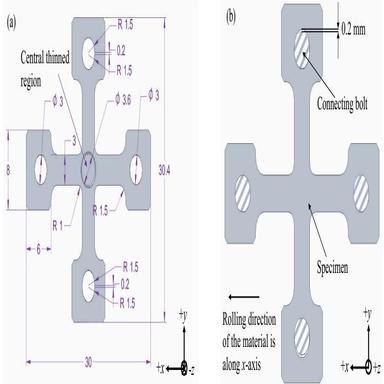
Design of (a) strain path change specimen and (b) assembly showing 0.2 mm travel of connecting bolt during strain path change.